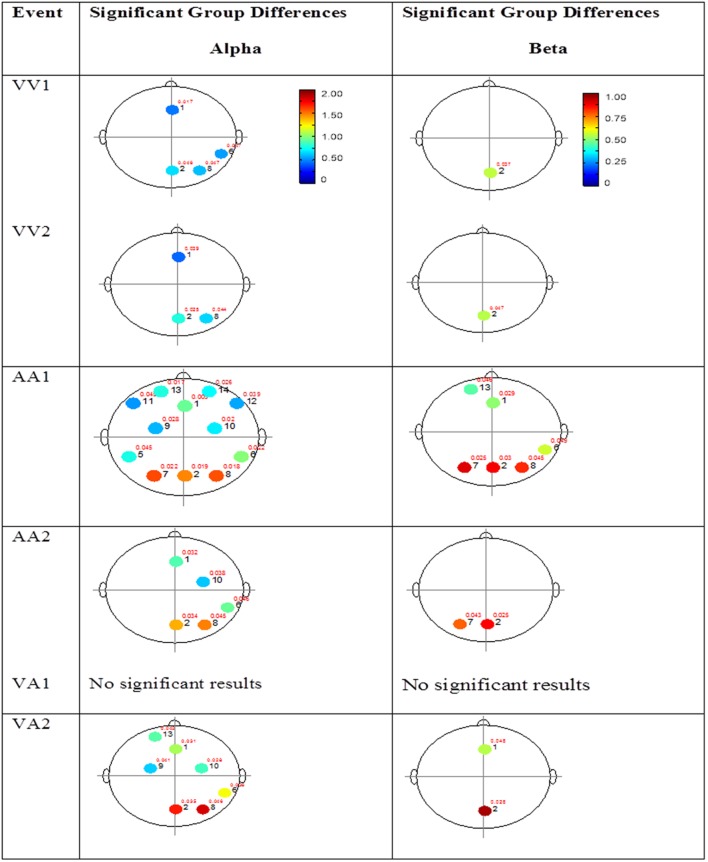
Session 1 alpha and beta EEG power group differences. Results for the alpha band (left) and beta band (right) are presented. Significant differences were determined using the Tukey–Kramer method for p < 0.05.